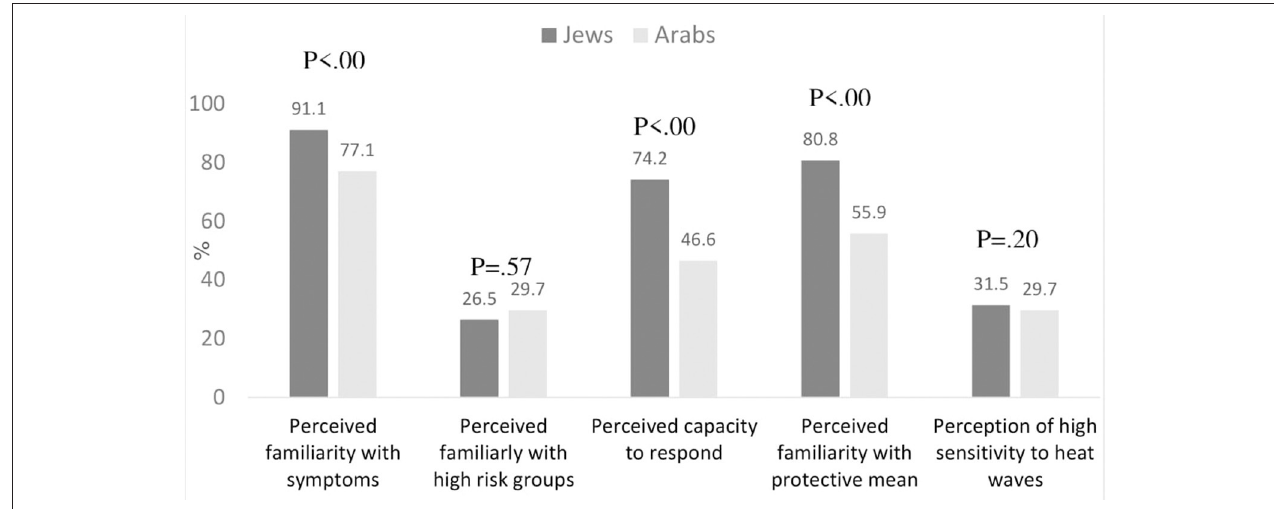
FIGURE 1 | Levels of awareness concerning heat waves among Jewish and Arab respondents.